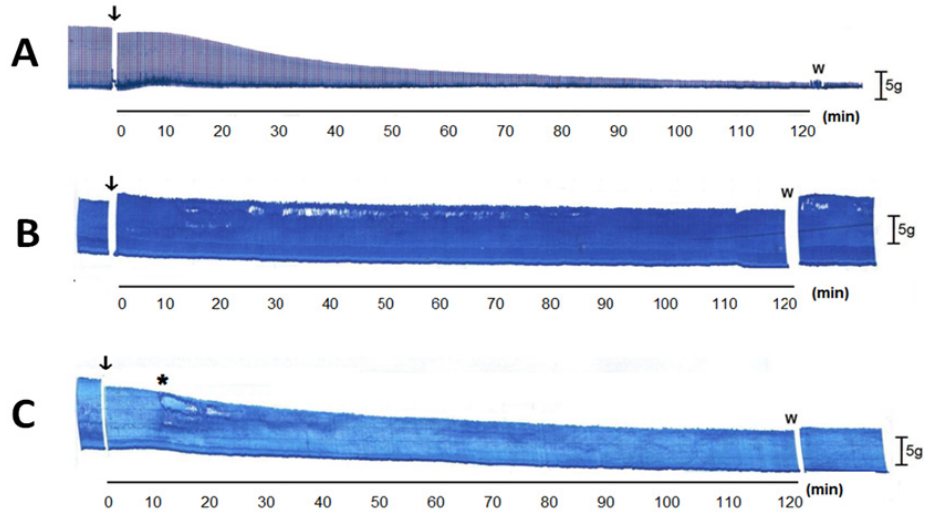
Figure 3. Neuromuscular responses of indirectly stimulated PND incubated with BthTX-I (20 µg/mL) in the absence ( A ) and presence ( B , C ) of 7,8,3'-trihydroxy-4'-methoxyisoflavone (TM, 200 µg/mL). In ( B ), TM (200 µg/mL) was preincubated with BthTX-I (20 µg/mL) at 37 °C for 30 min before addition to the bath, whereas in ( C ) TM (200 µg/mL) was added separately (at * ) 10 min after the addition of BthTX-I (20 µg/mL). Arrows show the moment of sample addition to the bath. Bar = tension of 5 g/cm; W =